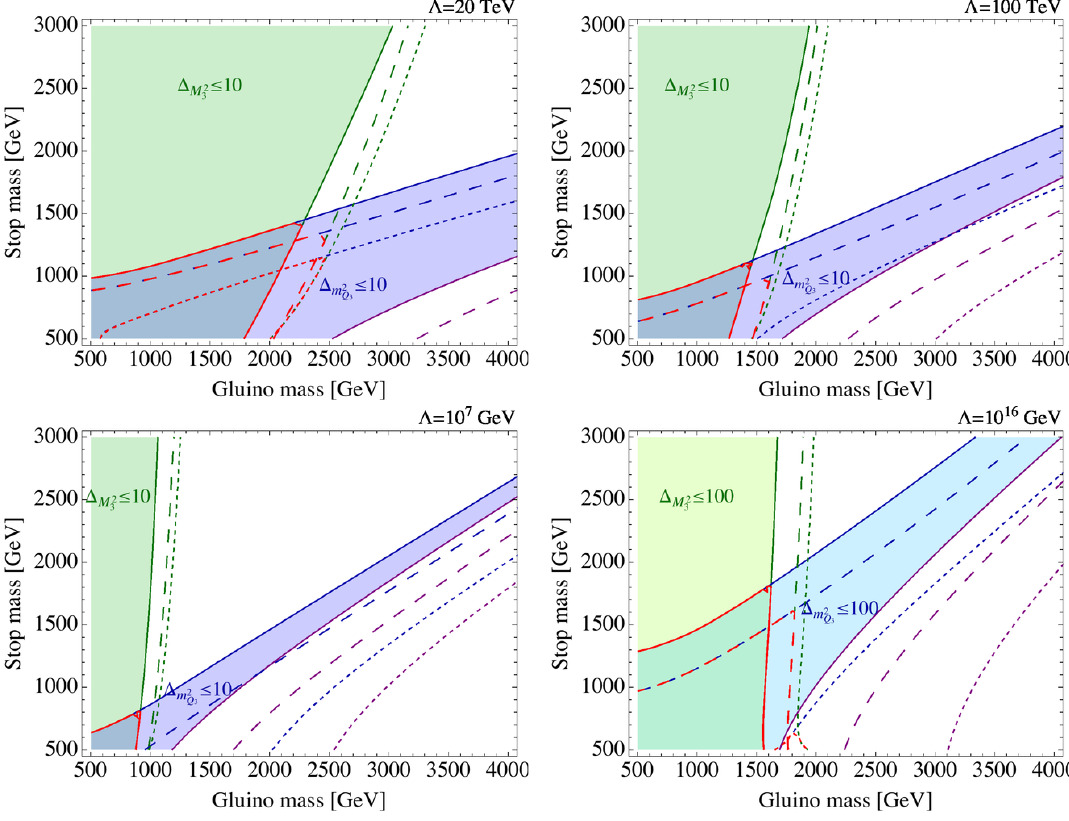
Figure 6 . Top: 10% (cid:12)ne tuned regions with (cid:3) = 20 TeV (left) and (cid:3) = 100 TeV (right), with respect to the gluino mass (green) and the stop mass (blue, delimited by blue and purple lines), for 1st/2nd generation squarks degenerate with the third generation (solid lines), at 5 TeV (dashed lines) and at 10 TeV (dotted lines). The wedge-shaped intersection (delimited by red lines) is the fully natural (cid:1) (cid:20) 10 region. Bottom: left: same as the other plots, but for (cid:3) = 10 7 GeV. Right: same as the other plots, but for (cid:3) = 10 16 GeV and 1% (cid:12)ne-tuning, that is, the lines and shaded regions correspond to (cid:1) (cid:20)